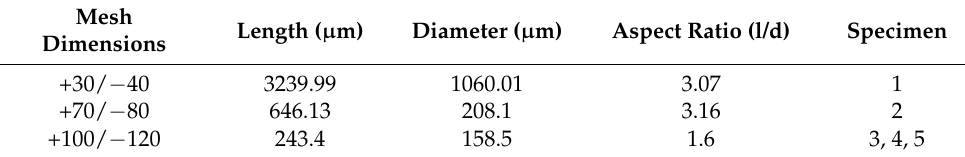
Table 2. Mean length, diameter, and aspect ratio of wood flour dimensions.